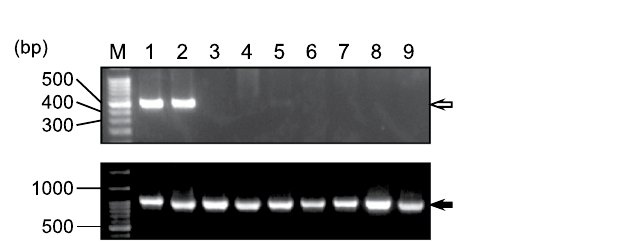
Figure 1. Location of primers in the 28S rRNA gene from Planocera multitentaculata and various flatworm species. ( a ) A schematic of the 28S rRNA gene of P. multitentaculata and various flatworm species, and locations of oligonucleotides used as primers for PCR and DNA sequencing. Arrows represent the location and direction of primers. ( b ) Electrophoretic pattern of PCR products from P. multitentaculata and various flatworm species. White arrow indicates PCR products specific to P. multitentaculata , and black arrow indicates those common to various flatworm species. Lane M, molecular weight marker; lanes 1 and 2, P. multitentaculata ; lane 3, Planocera reticulata ; lane 4, Planocera sp.; lane 5, Paraplanocera oligoglena ; lane 6, Callioplana marginata ; lane7, Discoplana gigas ; lane 8, Pseudostylochus obscurus ; lane 9, Notocomplana humilis . Full-length gels are included in a Supplementary Information file (Fig.